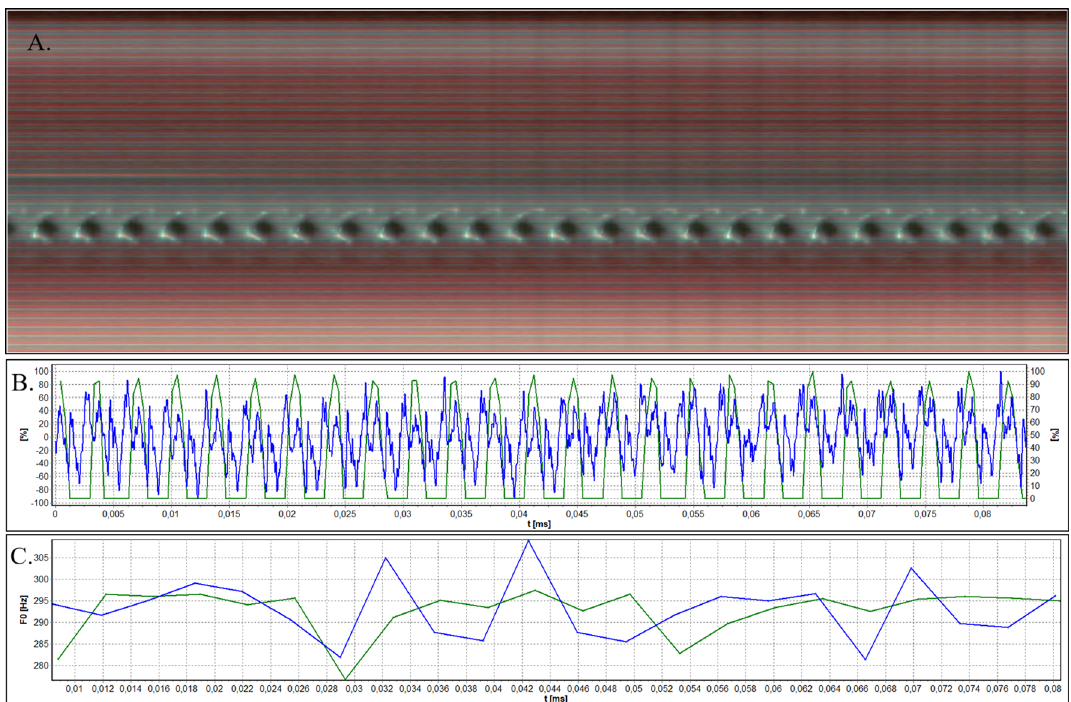
Figure 4. Analysis of HSV data acquired by means of flexible endoscope for Subject 1. ( A ) Videokymogram; ( B ) Comparison of the glottal width waveform obtained from a videokymogram (green line) and the audio signal oscillogram (blue line); ( C ) Comparison of F0 obtained from a videokymogram (green line) and acoustic voice analysis (blue line).